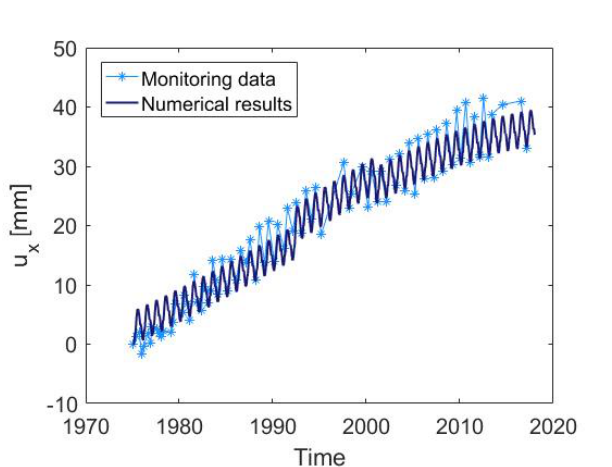
Figure 14. Patterns of damage after ( a ) 10 and ( b ) 30 years.